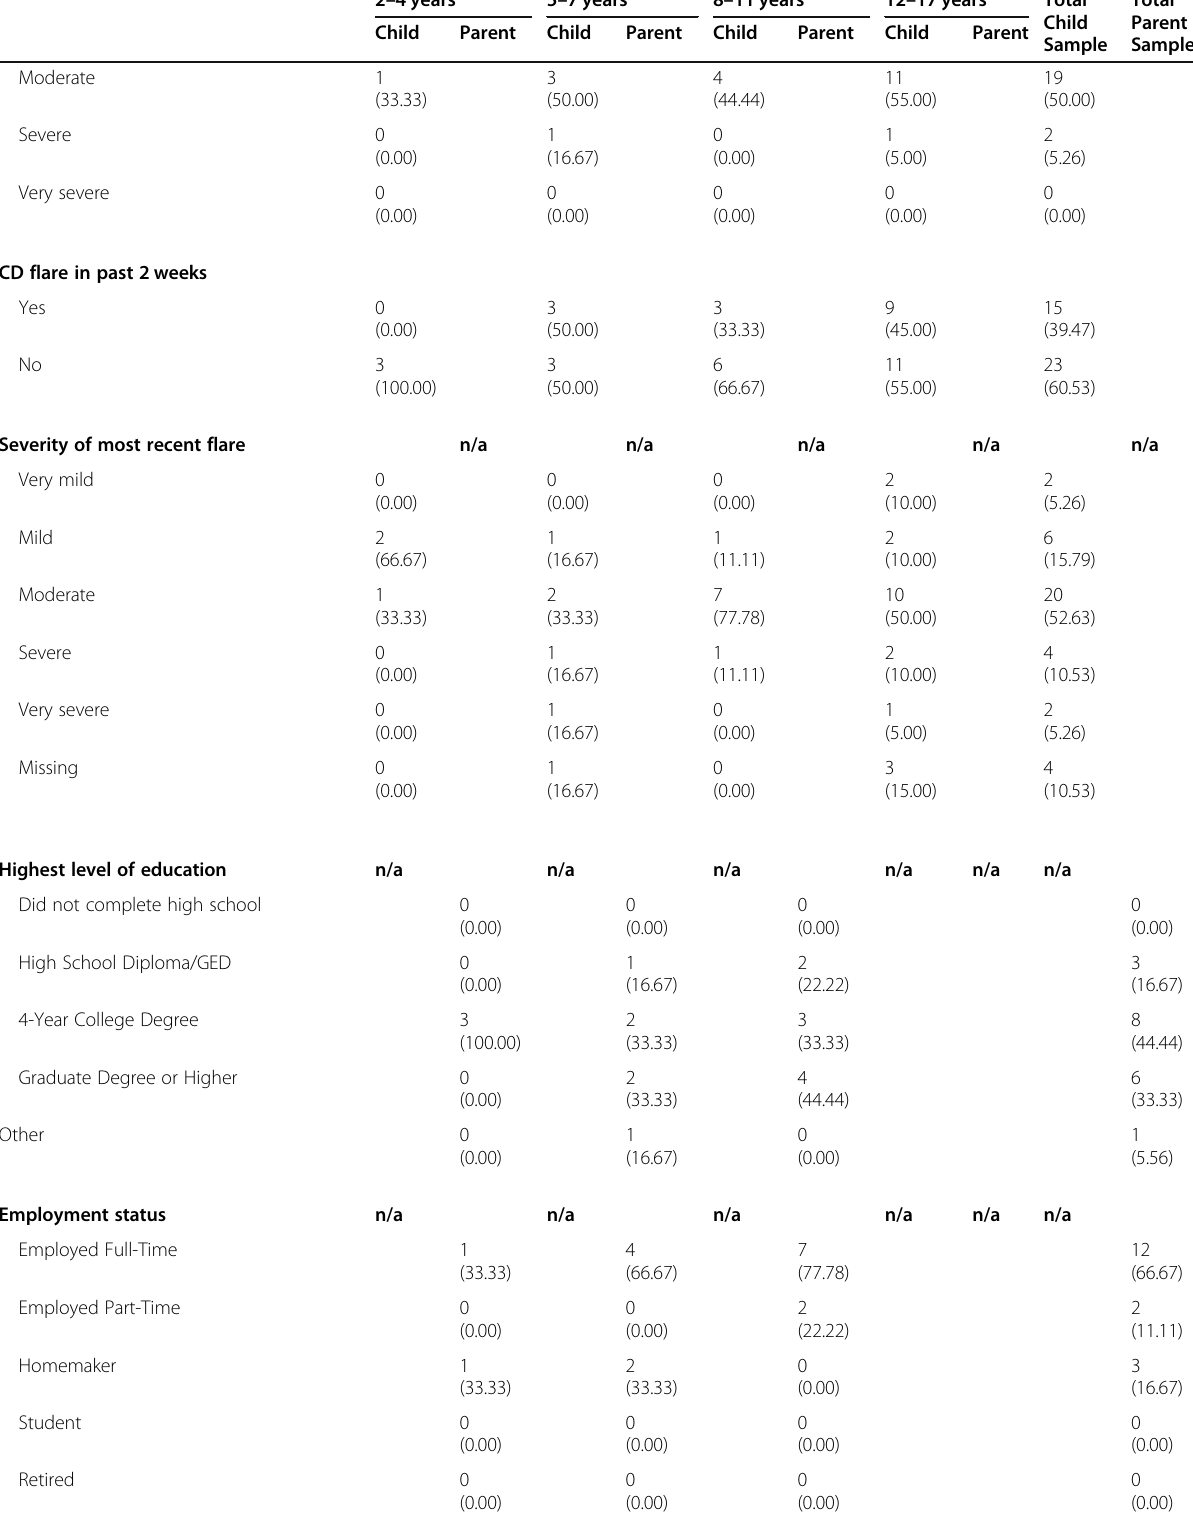
Table 1 Demographic Characteristics of Children and Parent Participants a